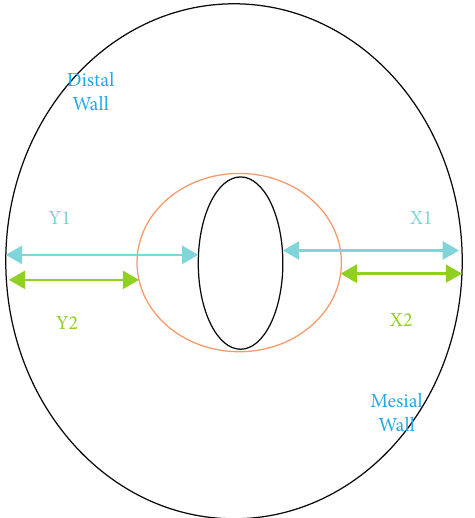
Figure 1: Schematic photo which explains the formula used for the transportation assessment.